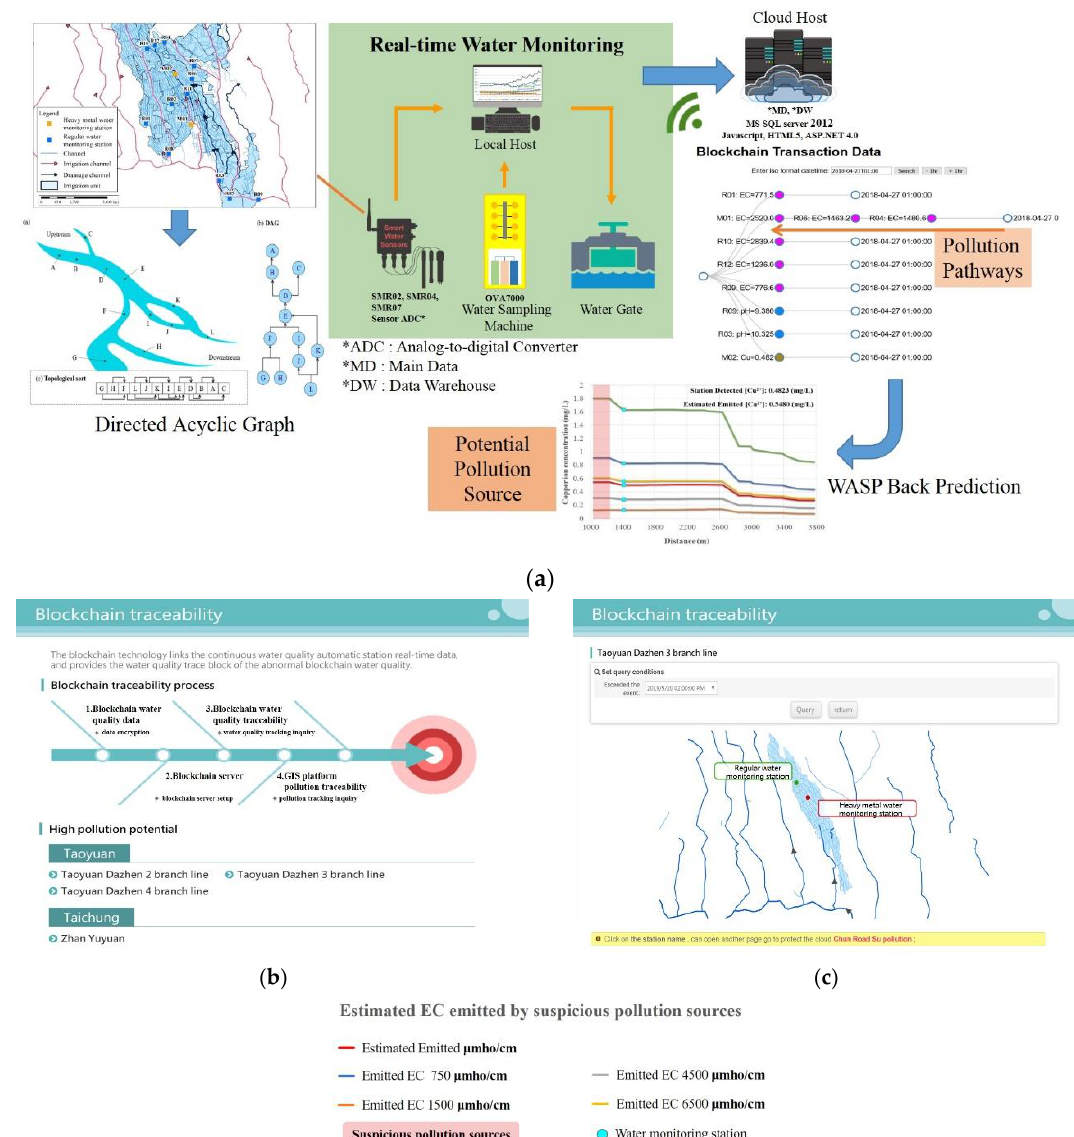
Figure 2. ( a ) framework of the monitoring system; ( b ) blockchain platform; ( c ) GIS platform.